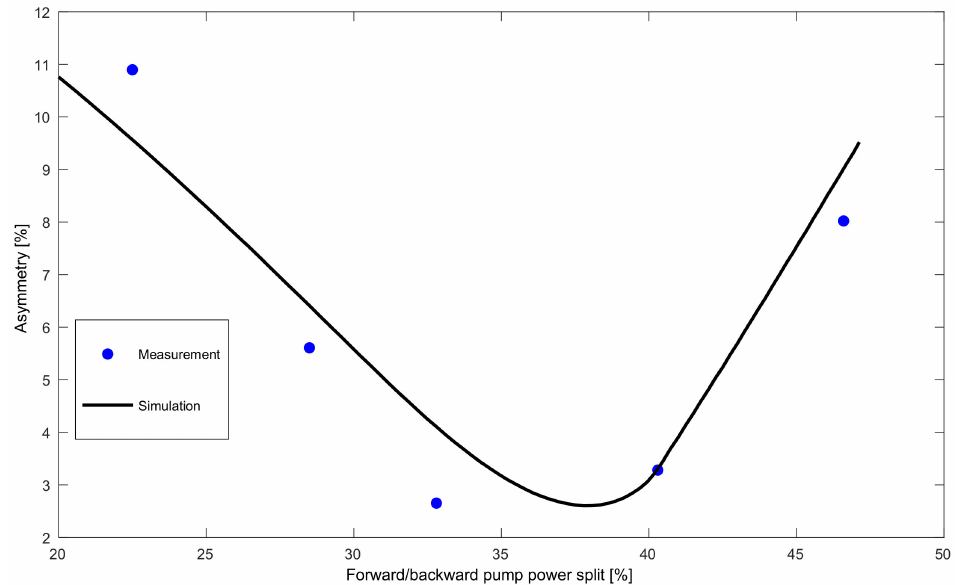
Figure 9. Asymmetry dependence on the forward pump power split measured at the central wave- length at 1545 nm in a 60 km